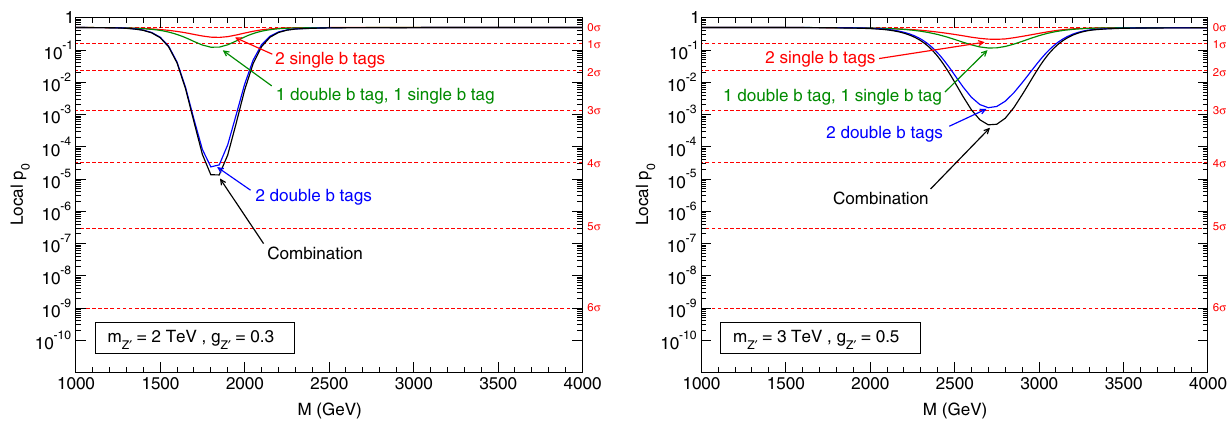
Fig. 8 Expected local p -value for the Z (cid:2) signal in the 6-channel combination, as well as in selected event classes